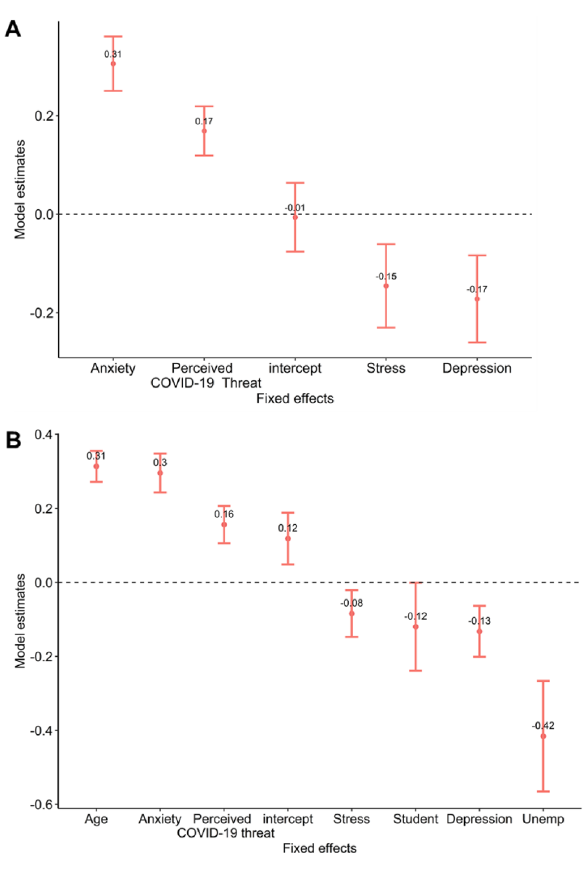
Figure 2. ( A ) Beta values and SEs for Model 1. ( B ) Beta values and SEs for Model 2. Dependent variable in both models is everyday altruism